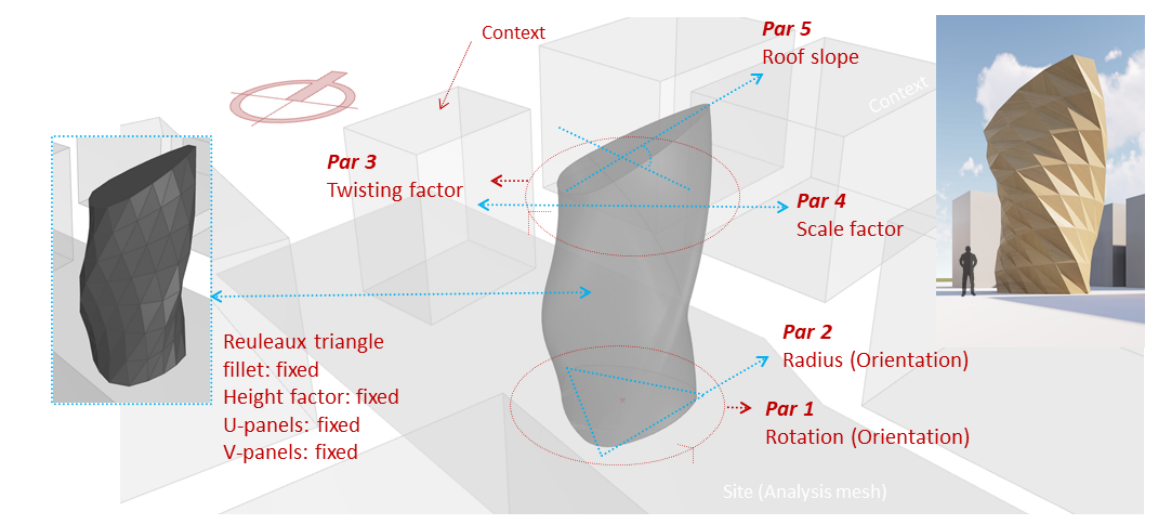
Fig. 2. Design parameters. minimum 2m to 3m with 10 movements, 0.1m for each step. The third variable is the twisting factor which has 50 variable movements with 5 units for each step, the factor ranged from the minimum value of -125 units to 125 units. The fourth variable is the scale factor with 10 movements with 5 units for each step. The variable ranged from -25